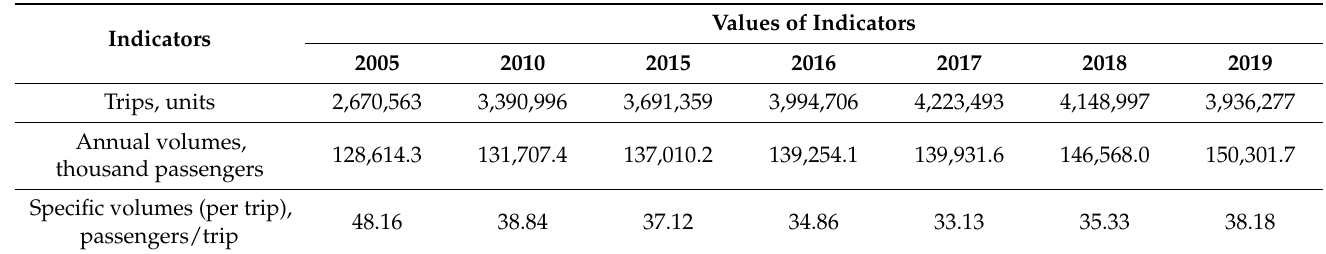
Table 5. Dynamics of the Tyumen CPPT system state in 2005–2019.